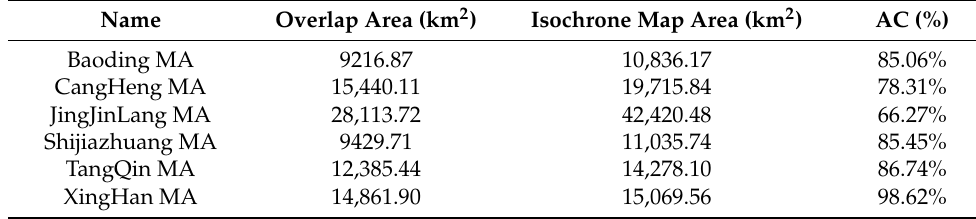
Table 3. Evaluation of the accuracy of the delineation results.